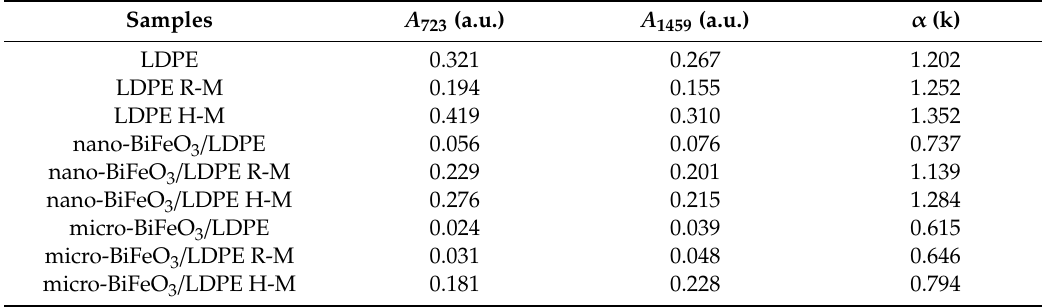
Table 1. Infrared absorption coe ffi cient and absorbance ratio.